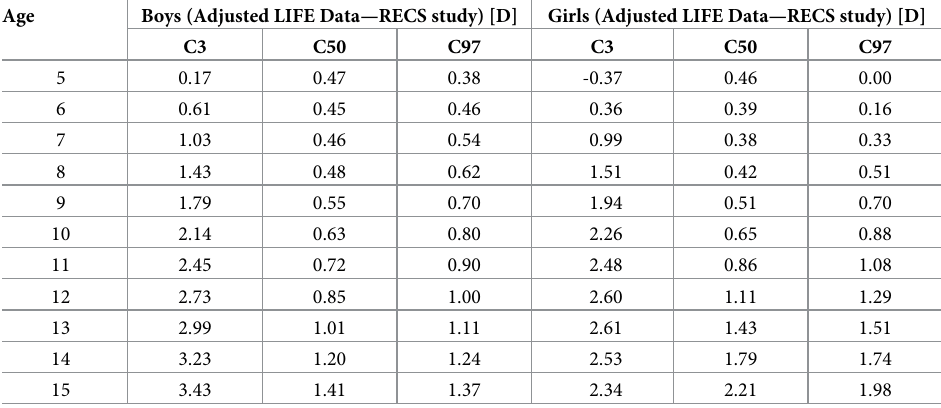
Table 2. Differences of 3 rd , 50 th and 97 th centile cutoffs in diopters for boys and girls between LIFE child data (adjusted by the calculation of Sankaridurg et al) and RECS